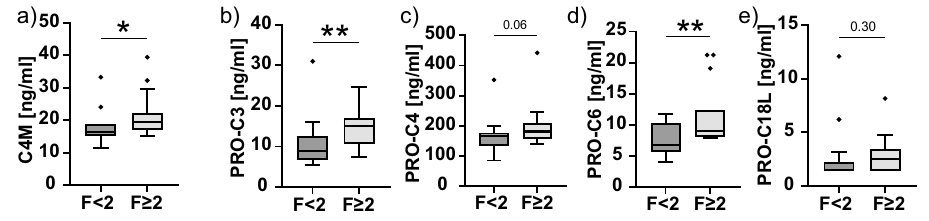
Figure 5. ECM biomarker levels in relation to fibrosis in a propensity-score matched cohort for graft age. Tukey Boxplots showing differences in biomarker levels between significant fibrosis (≥ F2) and no significant fibrosis (< F2). Each group consisted of 15 patients. Patients were matched using propensity-score matching for time after transplantation in months. Two groups were compared using Mann–Whitney-U test. *indicates p < 0.05; **indicates p <